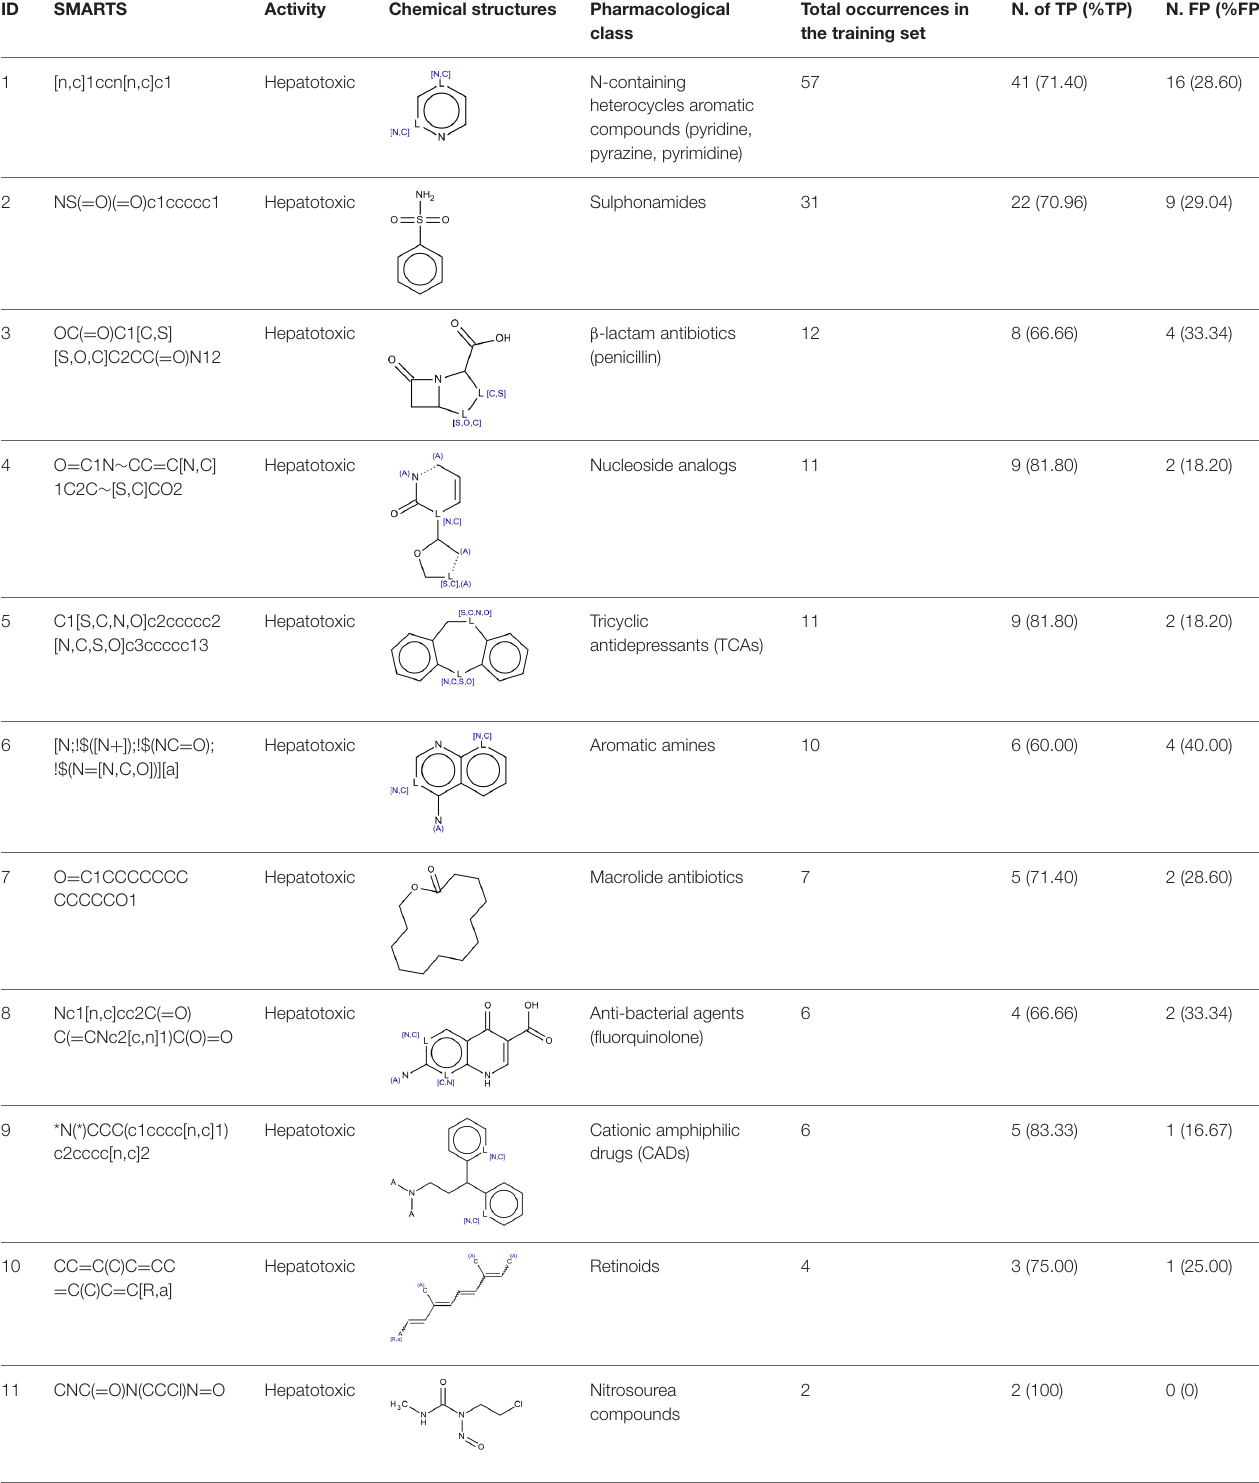
TABLE 1 | Manually extracted structural alerts (SAs) with the total number of occurrences and the number and percentage of true positive (TP) in the training set. ID SMARTS Activity Chemical structures Pharmacological